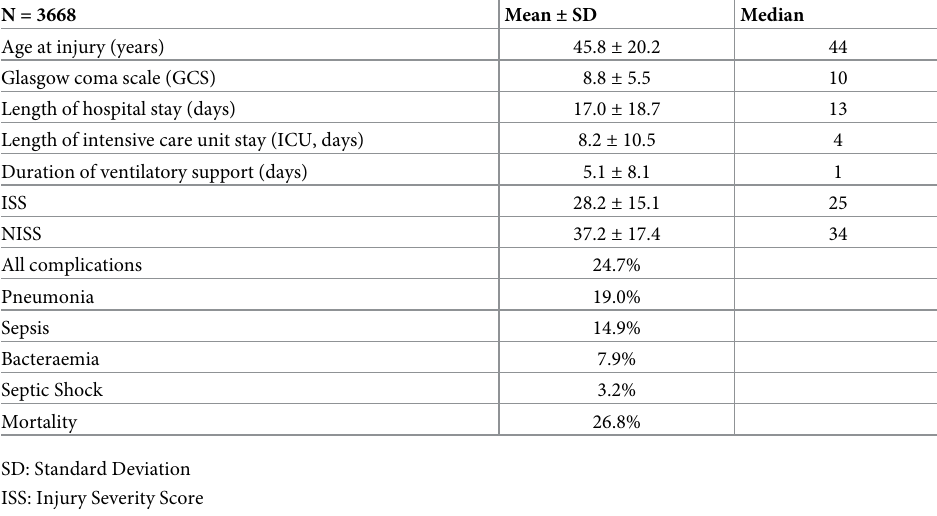
Table 1. Demographics and outcome